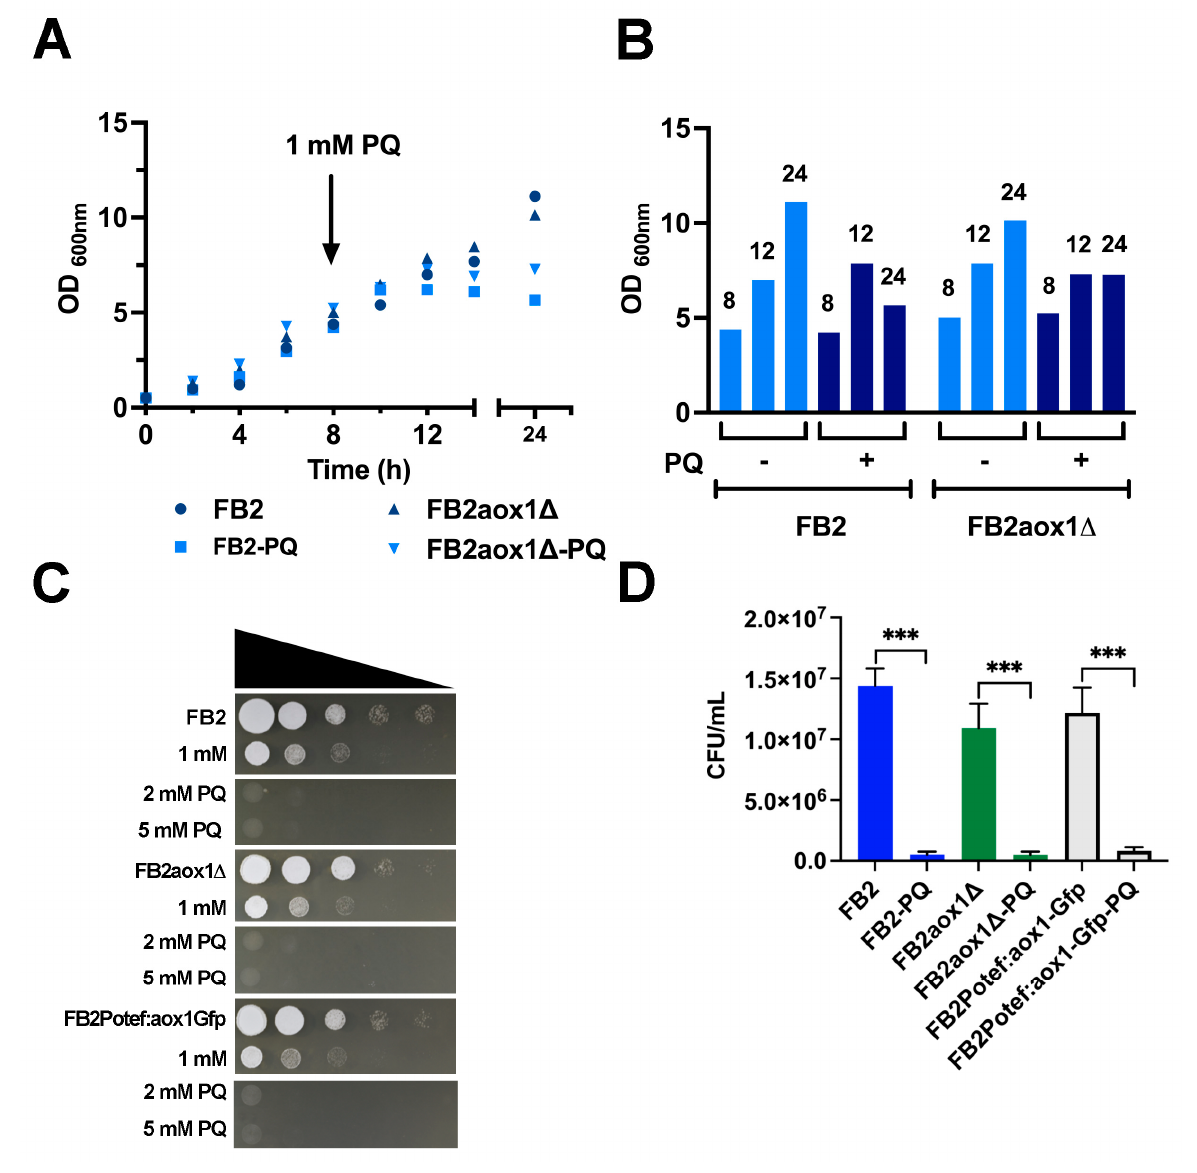
Figure 1. Inhibition of U. maydis growth by PQ. ( A ). Cells were inoculated in fresh YPD media at an initial concentration of 0.05 OD 600 nm and incubated at 28 ◦ C and 200 rpm. At the 8 h point, 1 mM PQ (final concentration) was added to the culture media, and cell growth was followed by measuring the OD 600 nm . The data are the mean of two experiments. ( B ) For clarity, the data points of 8, 12 and 24 h were displayed in a bar plot. ( C ) The spot assay was carried out with cells incubated for 4 h in the presence or absence of different concentrations of PQ (0, 1, 2, and 5 mM), harvested, and resuspended at 0.5 OD 600 nm . The 10-fold serial dilutions were prepared and spotted on YPD agar. The figure shows a representative result of four independent experiments ( n = 4). ( D ) The colony forming units per mL (CFU/mL) were estimated in cells incubated in the presence or absence of 1 mM PQ. Vertical bars indicate the standard error from at least four independent experiments ( n = 4–5). *** Indicates a significant difference at p < 0.05.